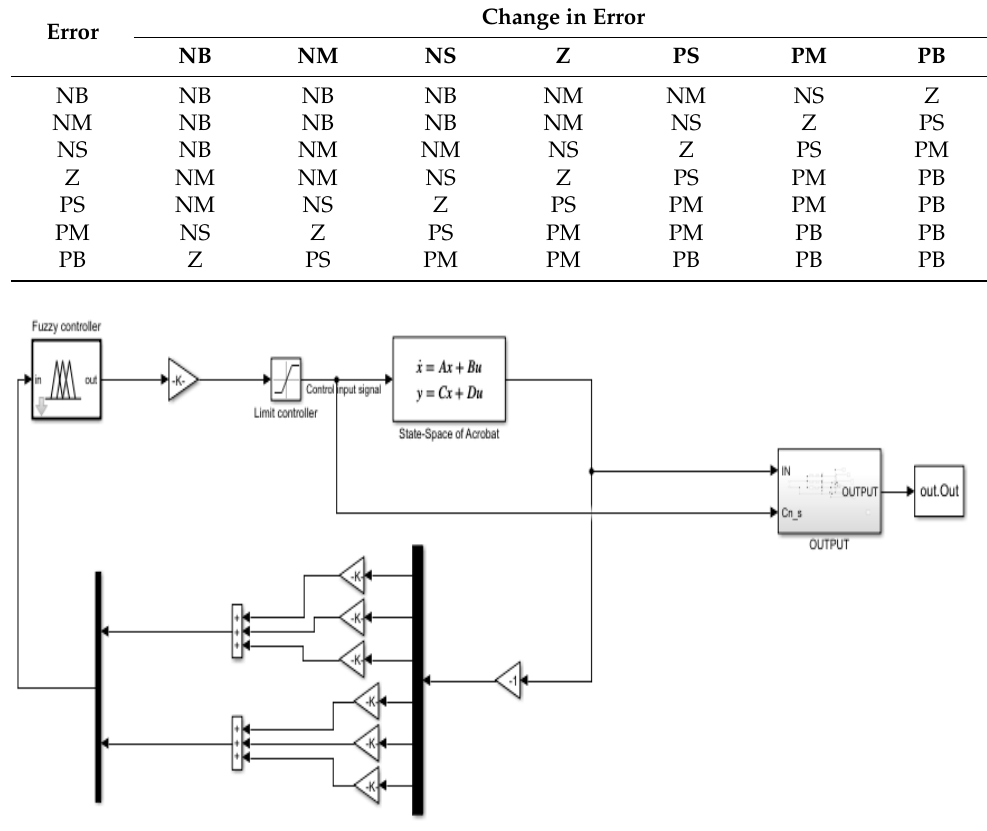
Figure 6. FLQR Figure 6. FLQR Simulink.